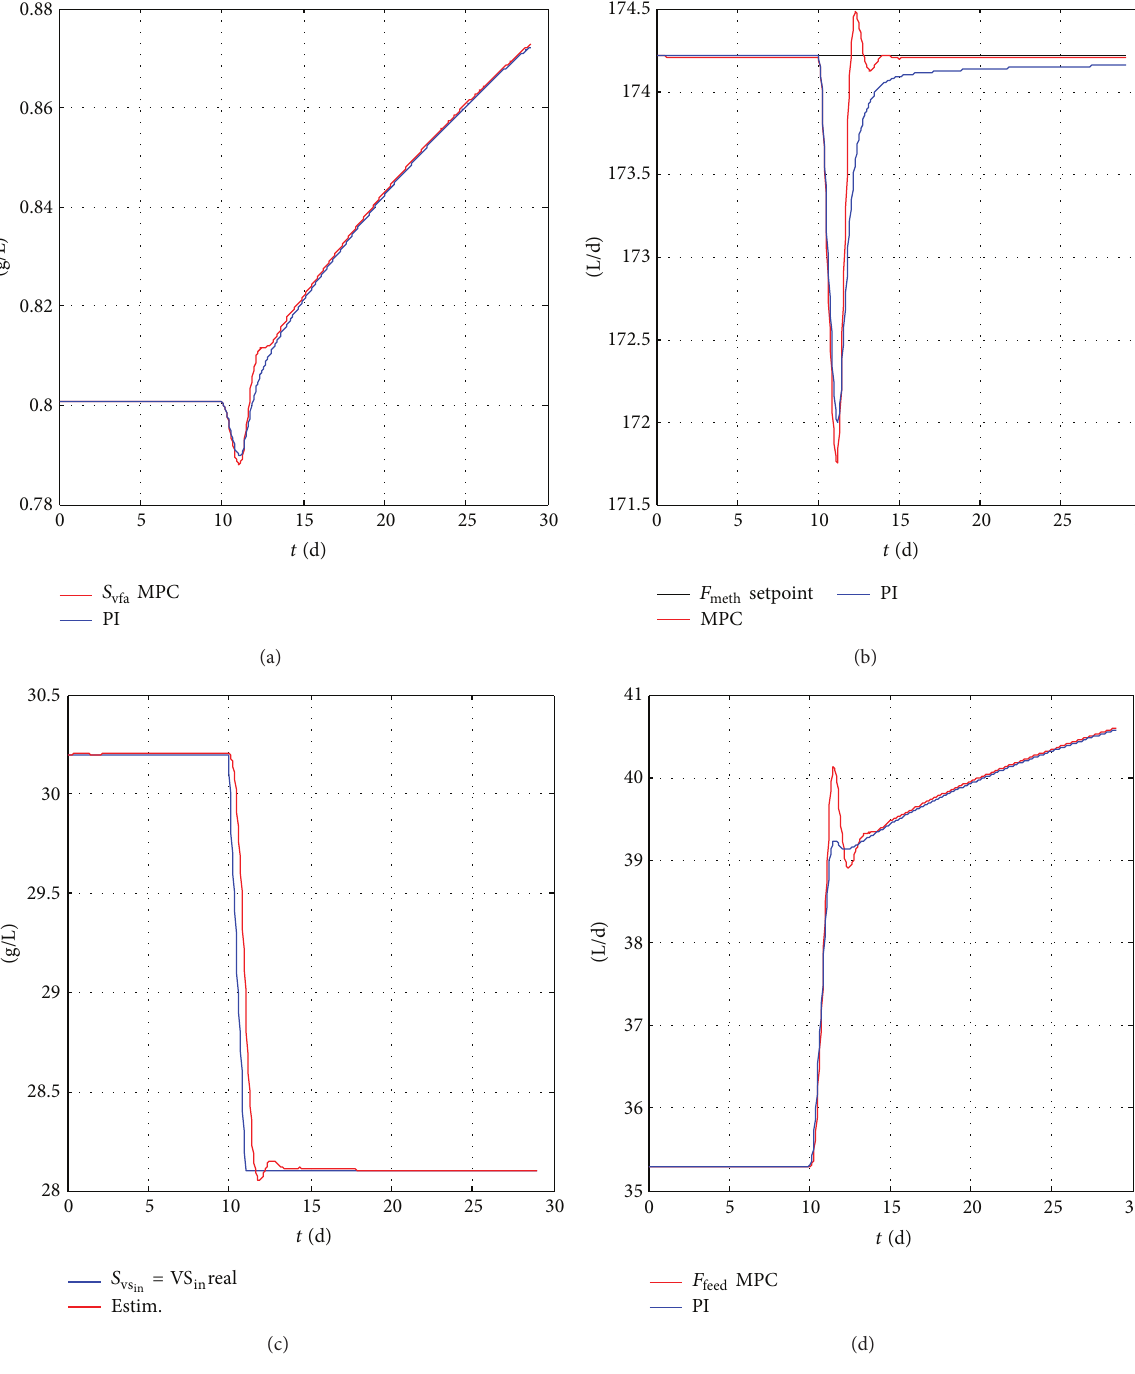
. The process perturbation is a change in 𝑆 meth